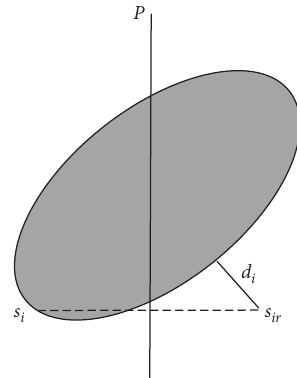
Figure 3: The 2D illustration of distance metric d